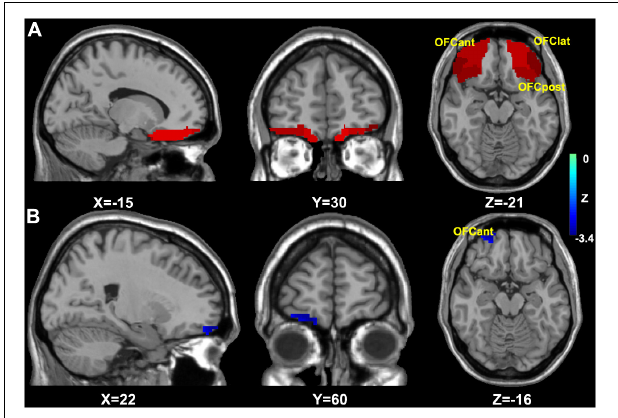
FIGURE 1 | The mask and results of OFC based VBM analysis. (A) The OFC analysis mask for VBM analysis; (B) the group difference of OFC based VBM analysis, then the result (right OFCant) was selected for OFC FC analysis. OFC, orbital frontal cortex; OFCmed, medial OFC; OFCant, anterior OFC; OFClat, lateral OFC; OFCpost, posterior OFC; FC, functional